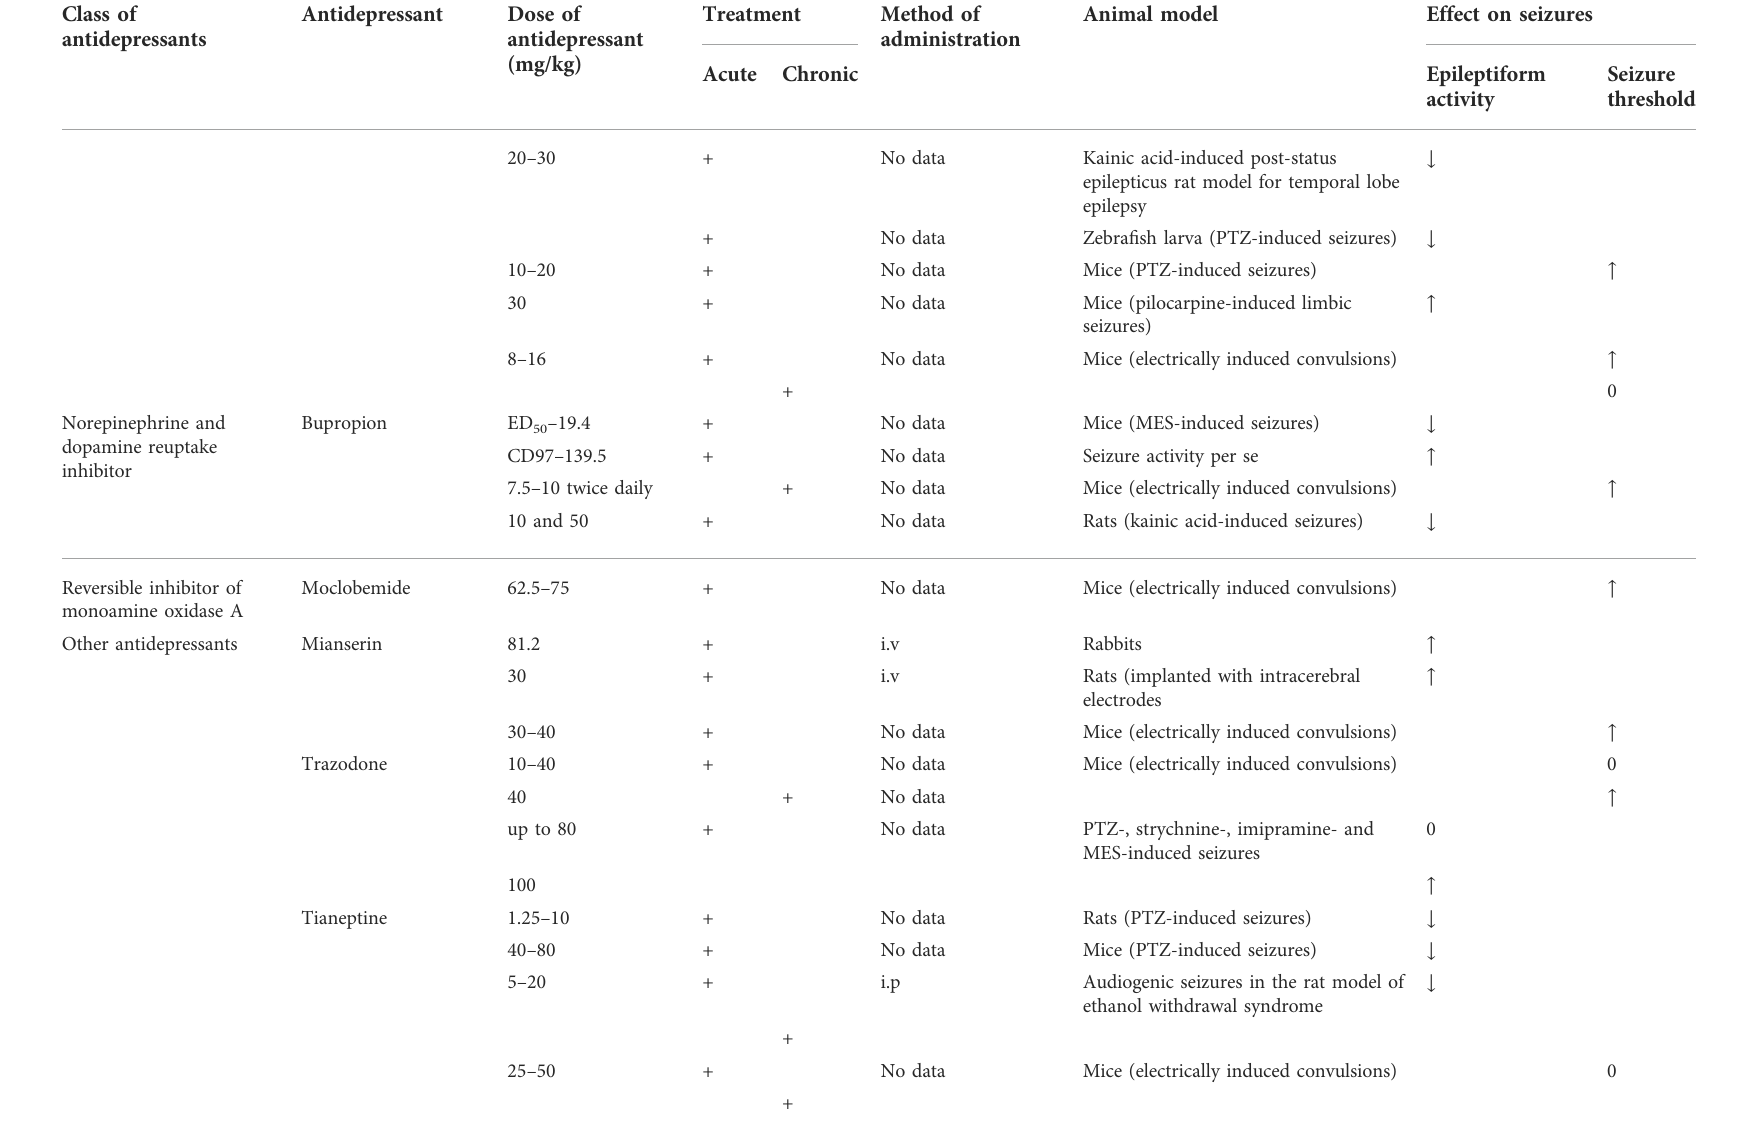
TABLE 1 ( Continued ) In fl uence of various antidepressant drugs on the seizure threshold and epileptiform